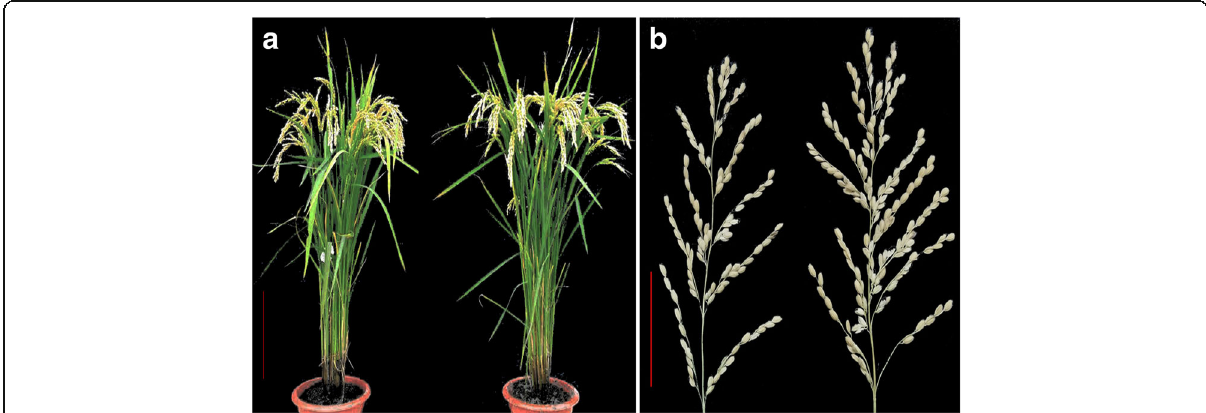
Fig. 6 Plant type and the main panicle of Kongyu 131 and its improved line BC 4 F 2 -350C05 at Changchun. a Plant type. Kongyu 131 (left), BC 4 F 2 - 350C05 (right); scale bar represents 20 cm. b Main panicle. Kongyu 131 (left), BC 4 F 2 -350C05 (right); scale bar represents 5 cm